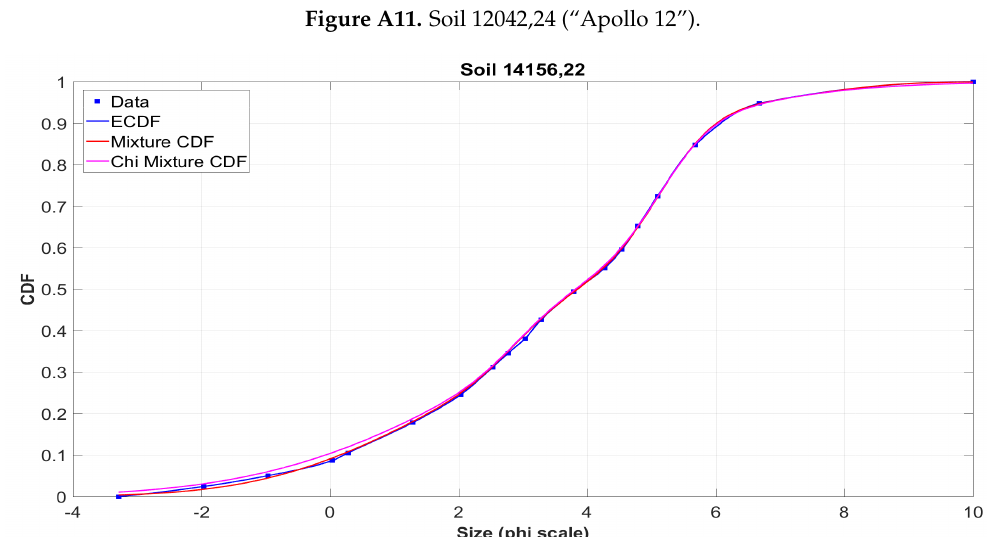
Figure A12. Soil 14156,22 (“Apollo